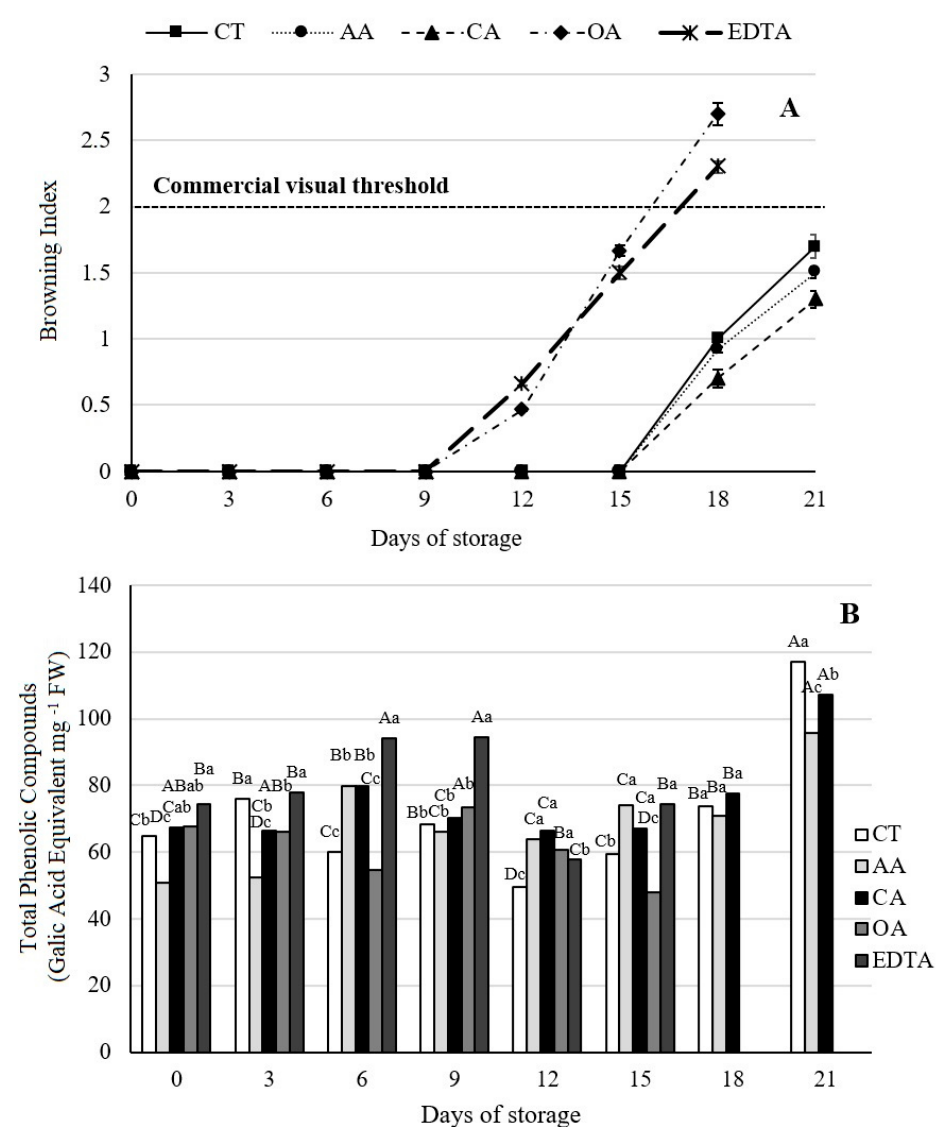
Figure 1. Browning index (BI) ( A ) and total phenolic compounds (TPC) (mg Gallic Acid Equivalents 100 g − 1 FW) ( B ) in minimally-processed escarole treated with antioxidants and stored at 0 °C and 90–95% relative humidity for 21 d. Vertical bars represent the standard deviation of the mean ( n = 3). Means followed by different uppercase letters within each day of storage and lowercase letters between treatments differ from each other by Tukey’s test ( P ≤ 0.01). CT: control; AA: 1% ascorbic acid; CA: 1% citric acid; OA: 1% oxalic acid; and 2% EDTA: ethylenediaminetetraacetic acid.